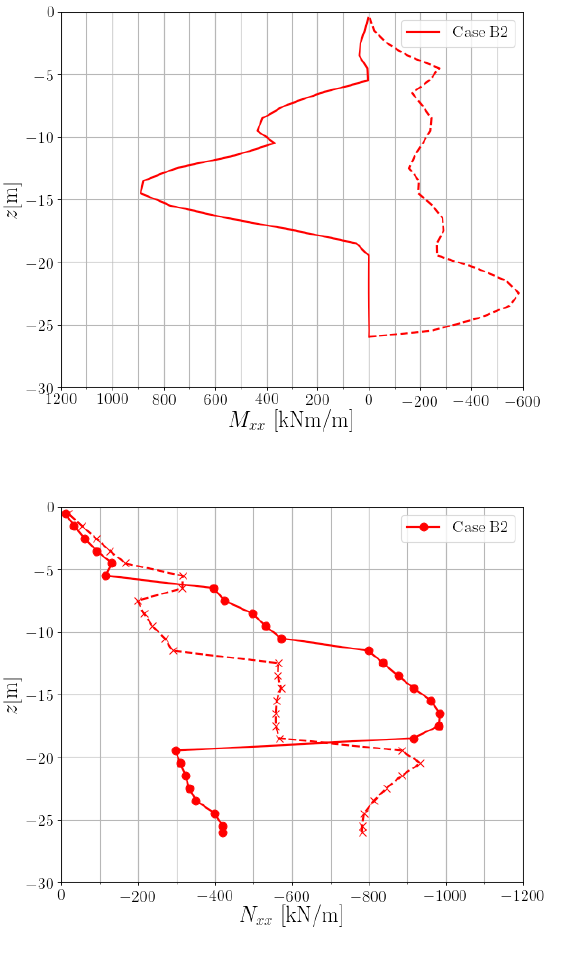
Figure 12: Envelope of characteristic bending moments (Case B2) and corresponding membrane forces at the time instance when the foundation raft is